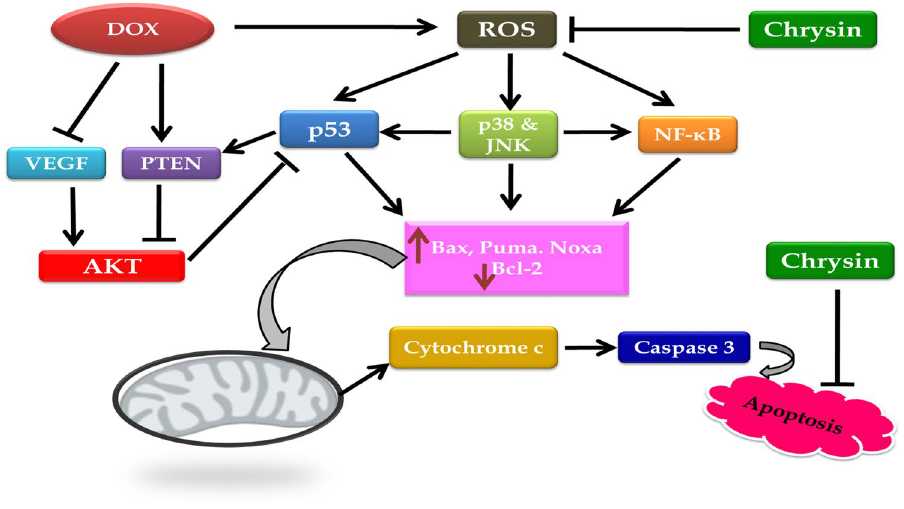
Figure 7. Schematic diagram of the signal transduction pathways implicated in the cardioprotection of chrysin against DOX-induced